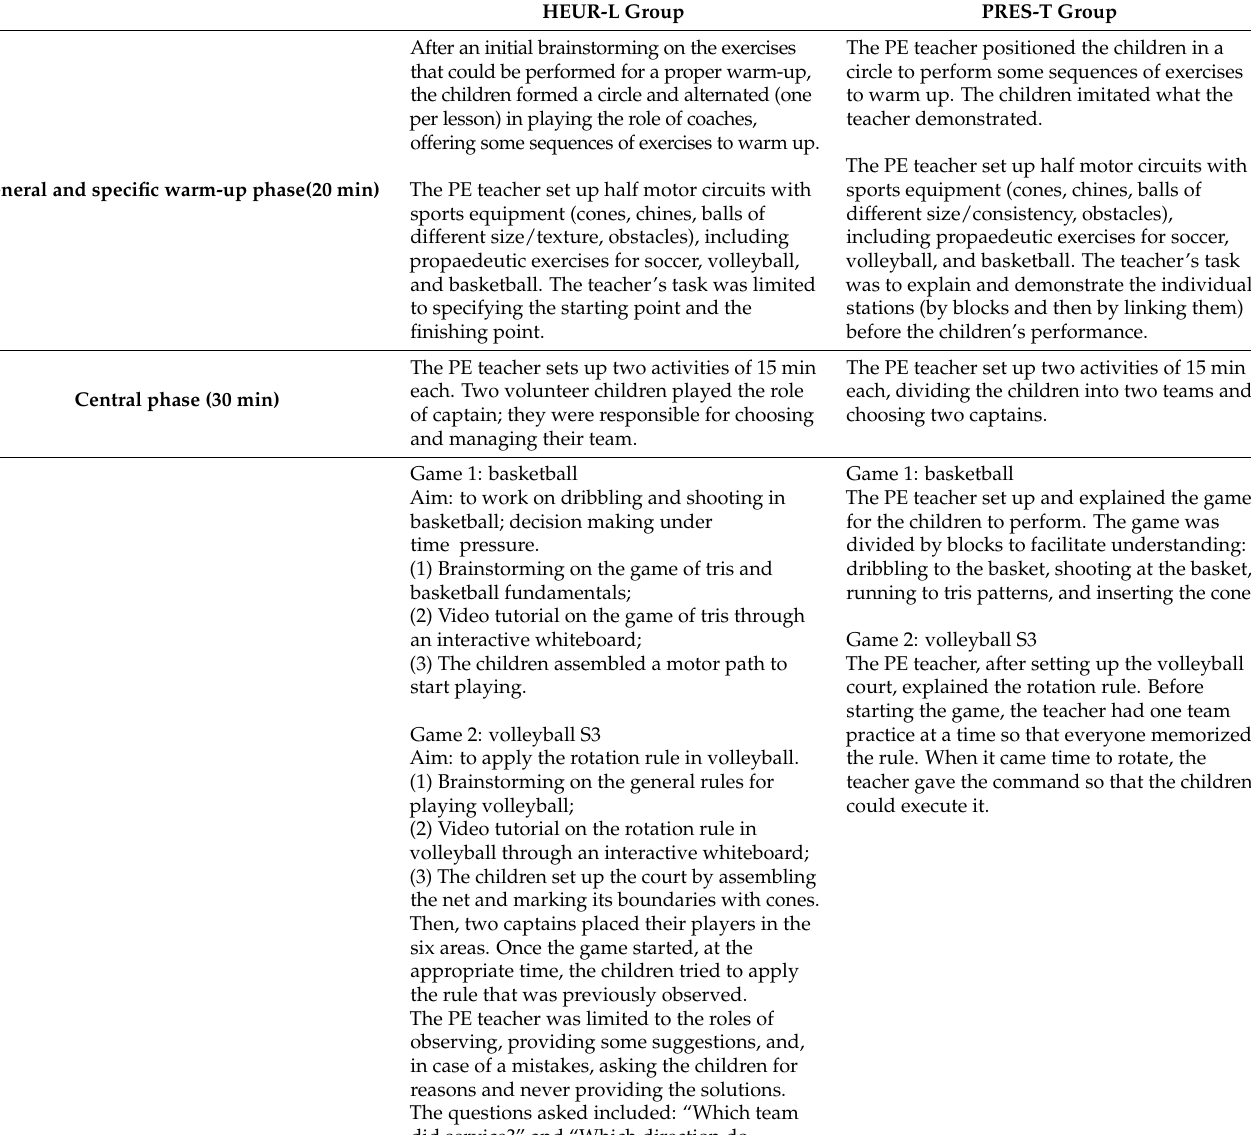
Table 1. Example of the activity performed using two teaching methods by the HEUR-L and PRES-T